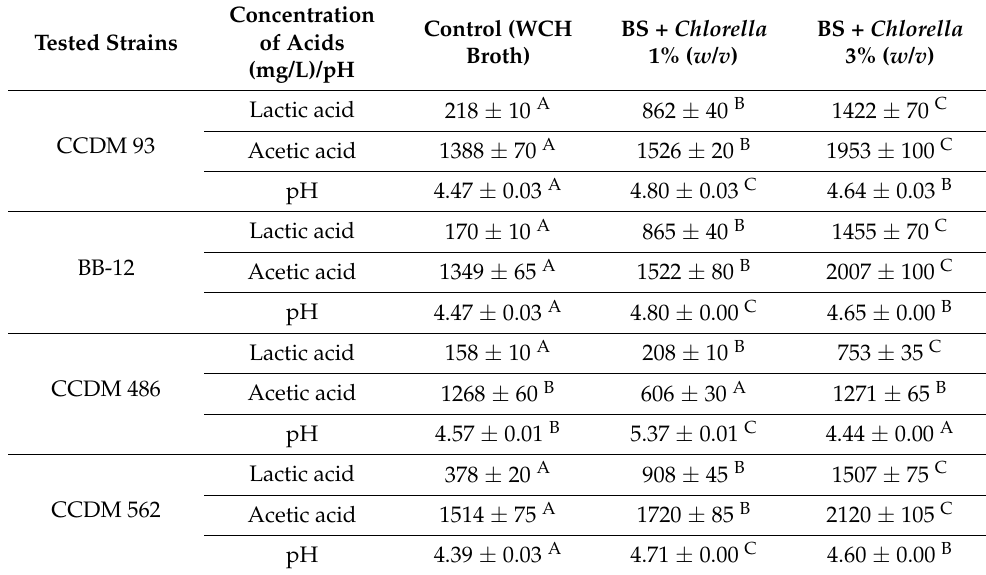
Table 1. Production of lactic and acetic acids and pH values following 24 h cultivation and.